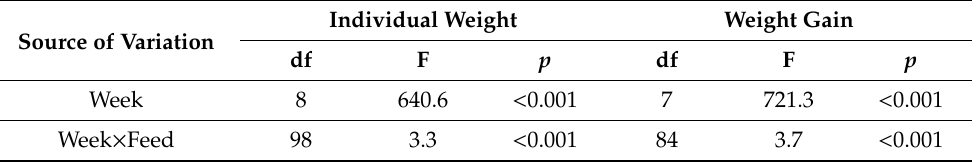
Table 3. Results of the multidimensional test (Wilk’s) for multiple